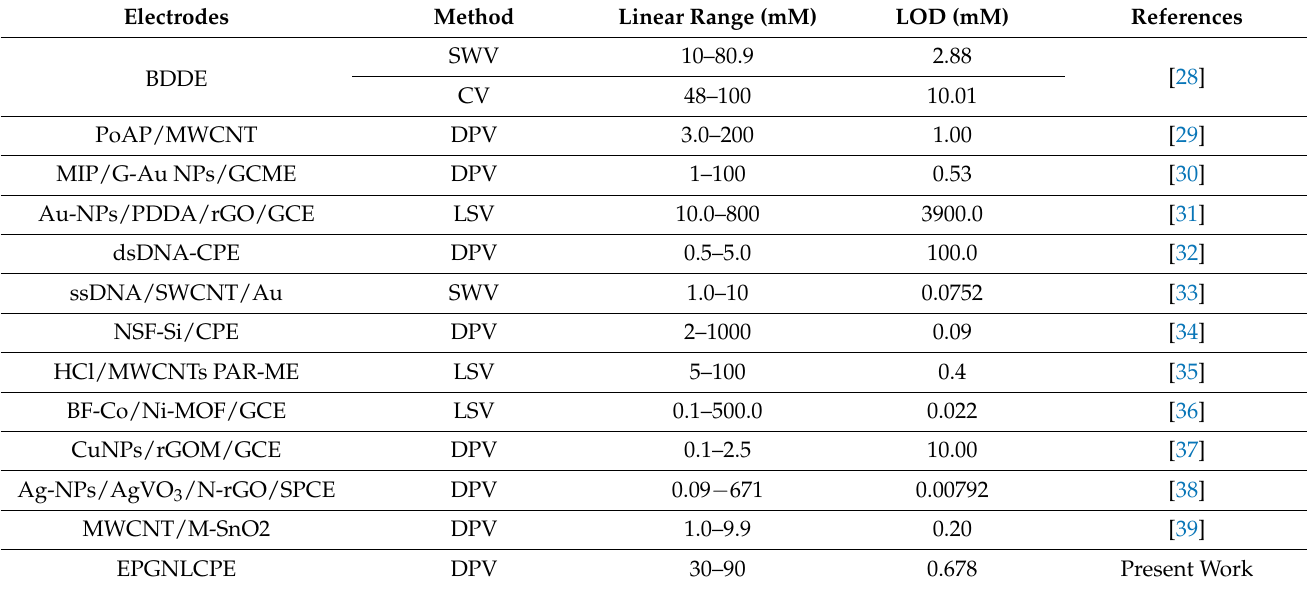
Figure 10. ( a ) Differential pulse voltammetry of LN with concentrations varying from 30.0 μ M to vs. I pa .